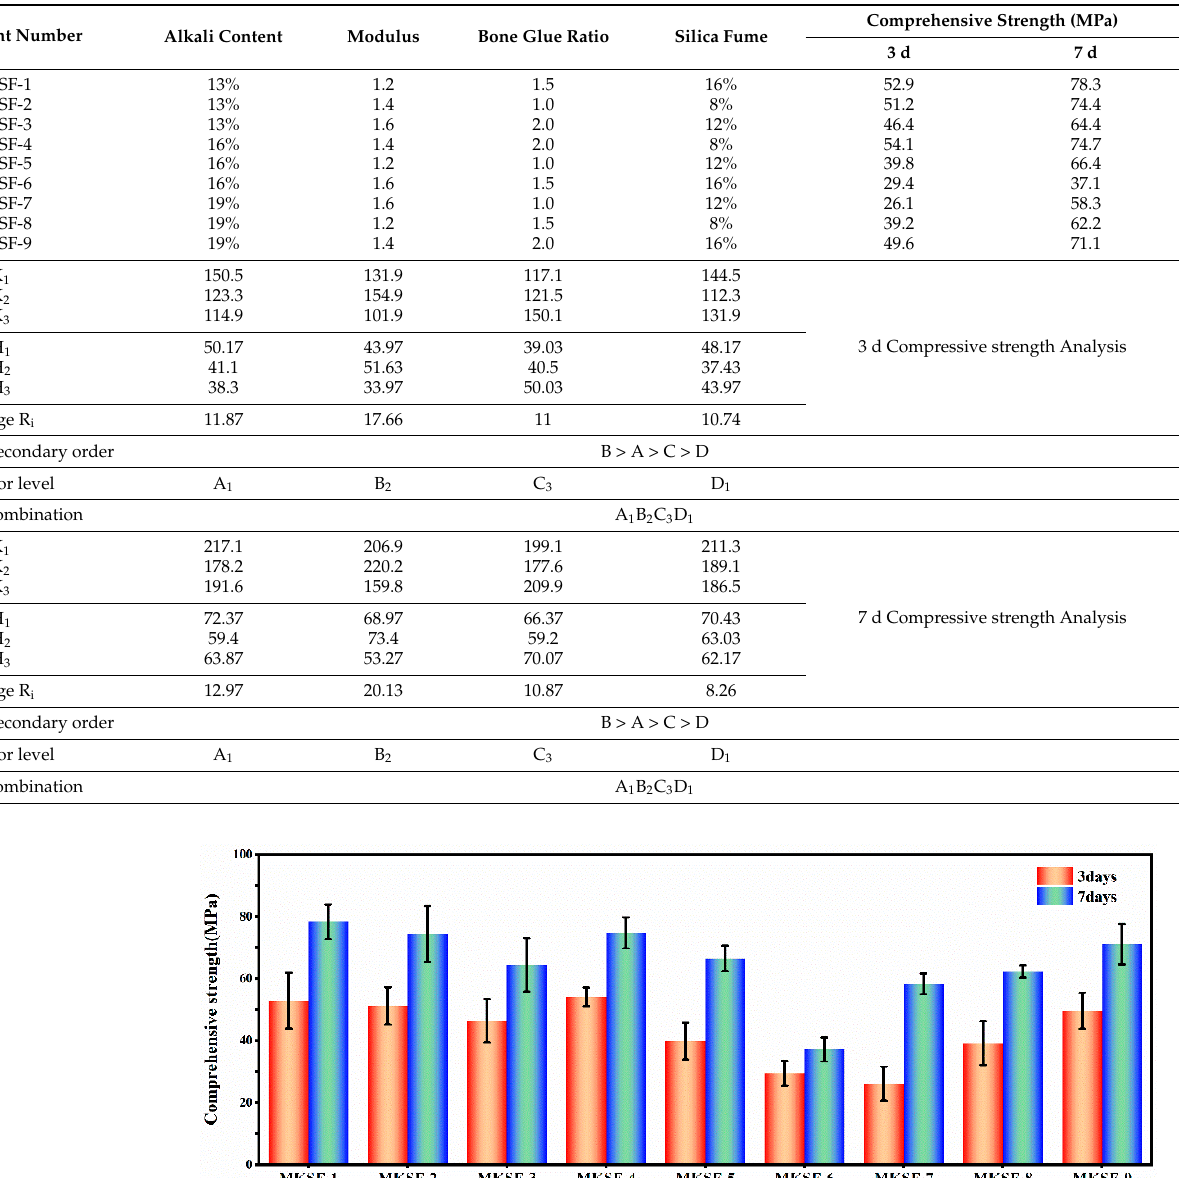
Figure 5. Orthogonal test 3 days, 7 days compressive strength 3.2. Influence of defoamer on the properties of geopolymer mortar.